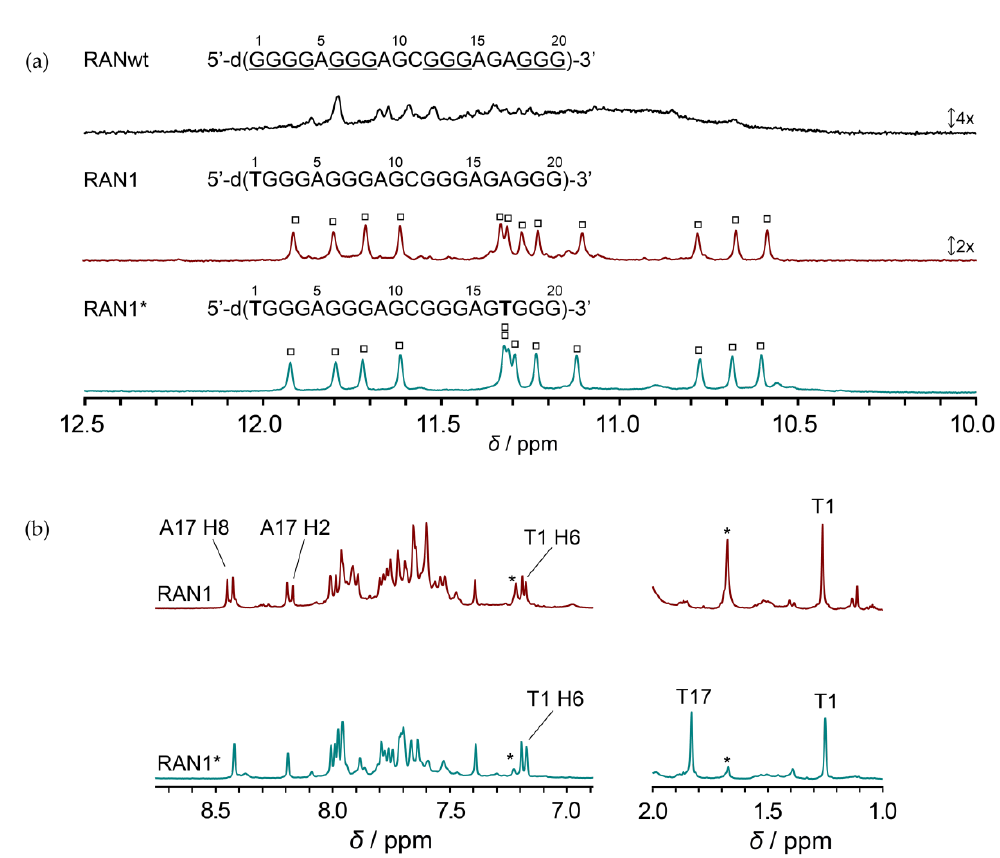
Figure 1. Comparison of 1D 1 H NMR spectra. ( a ) Imino regions of 1 H NMR spectra of wild-type (RANwt) and modified (RAN1 and RAN1*) G-rich sequences from the regulatory region of the RANKL gene in the presence of 50 mM KCl, 10 mM potassium phosphate buffer, 0.6 mM DNA concentration per strand, pH 7.0 and 25 °C on a 600 MHz NMR spectrometer. Signals of 12 imino protons, which indicate the formation of three G-quartets, are marked with squares. ( b ) Detailed comparison of aromatic and methyl regions of 1D 1 H NMR spectra of RAN1 and RAN1*. Signals used in evaluation of the population of the unknown species in the sample are marked with an asterisk.